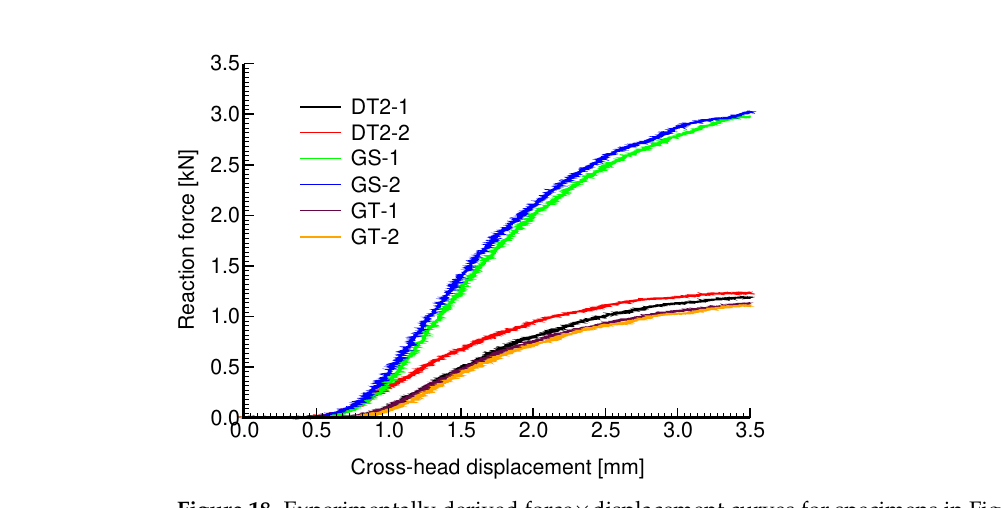
Figure 18. Experimentally derived force × displacement curves for specimens in Figure 17a–c.